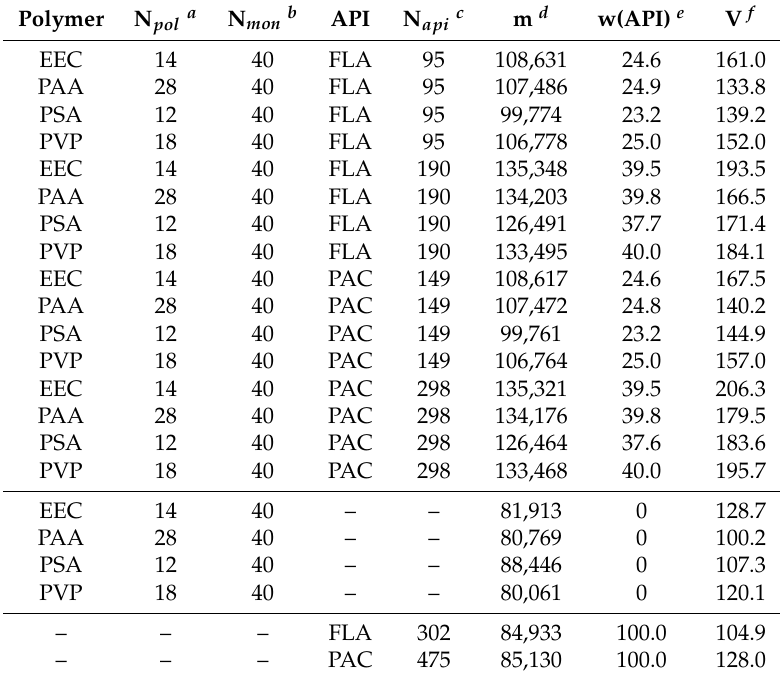
Table 1. Details of the systems used here for MD simulations. Molecular content and average volumes for API–polymer blends, and pure